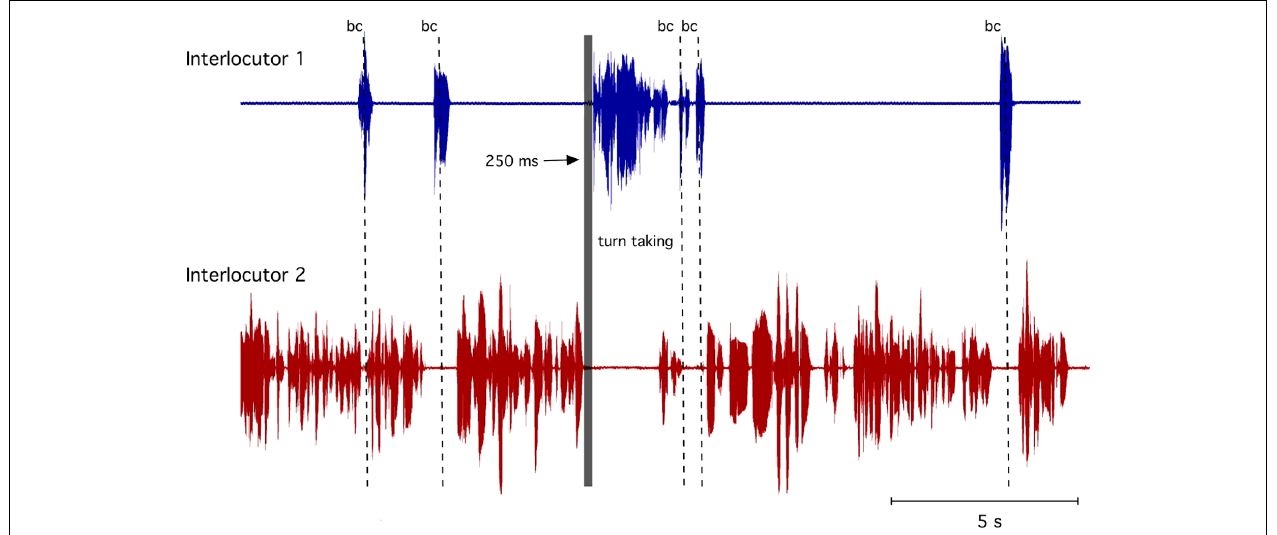
FIGURE 1 | Example of a dialog with accurate turn-taking (within 250 ms) indicated by the gray bar and backchannel (bc) indicated by the dotted